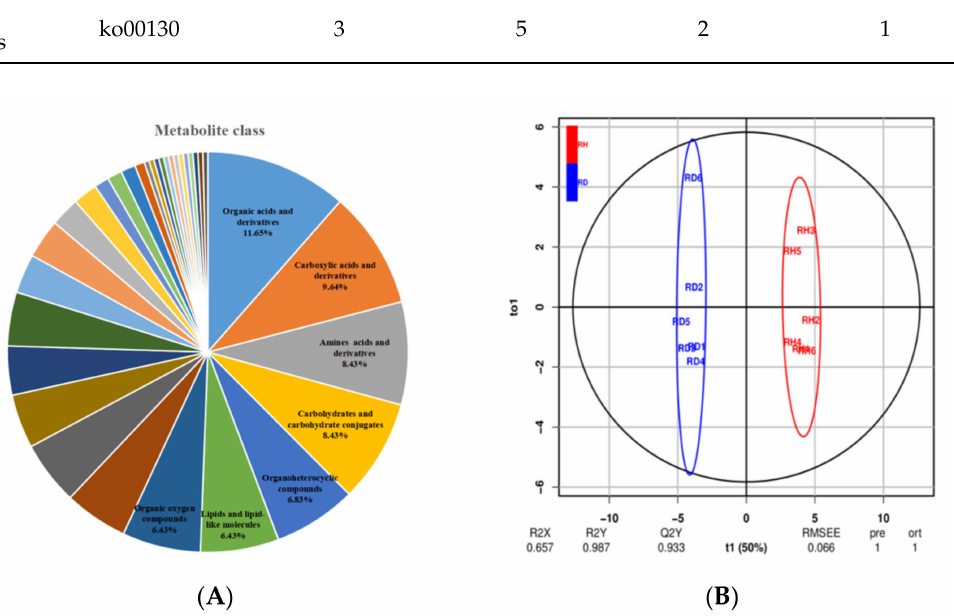
Figure 3. ( A ) Sector graph of metabolite classification. ( B ) OPLS-DA scatter plot of resistant line sample infected or uninfected with Co.